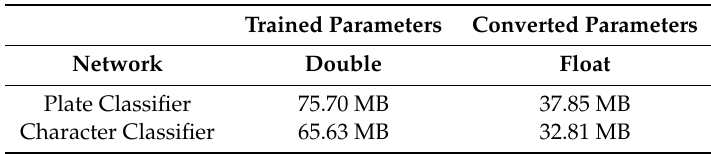
Table 2. Memory consumption of trained and converted